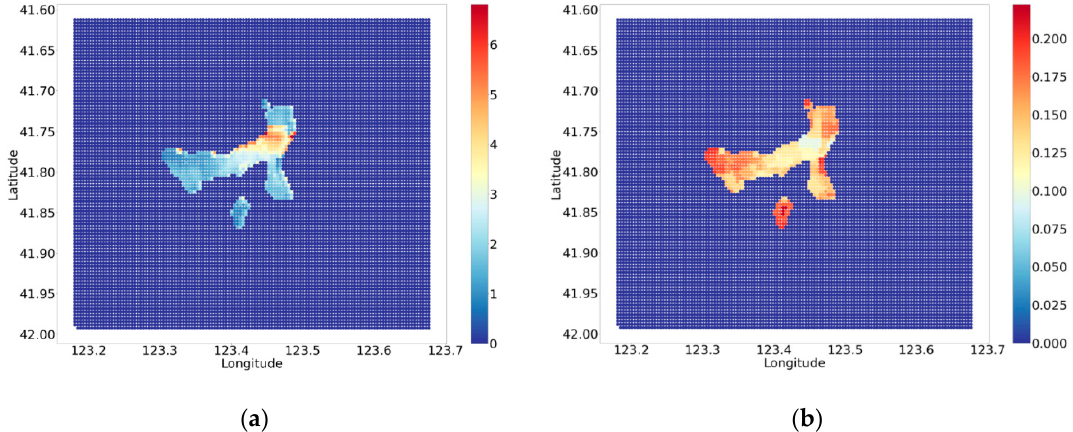
Figure 12. ( a ) The spatial distribution of the potential of accident time. ( b ) The spatial distribution of the isolation form.